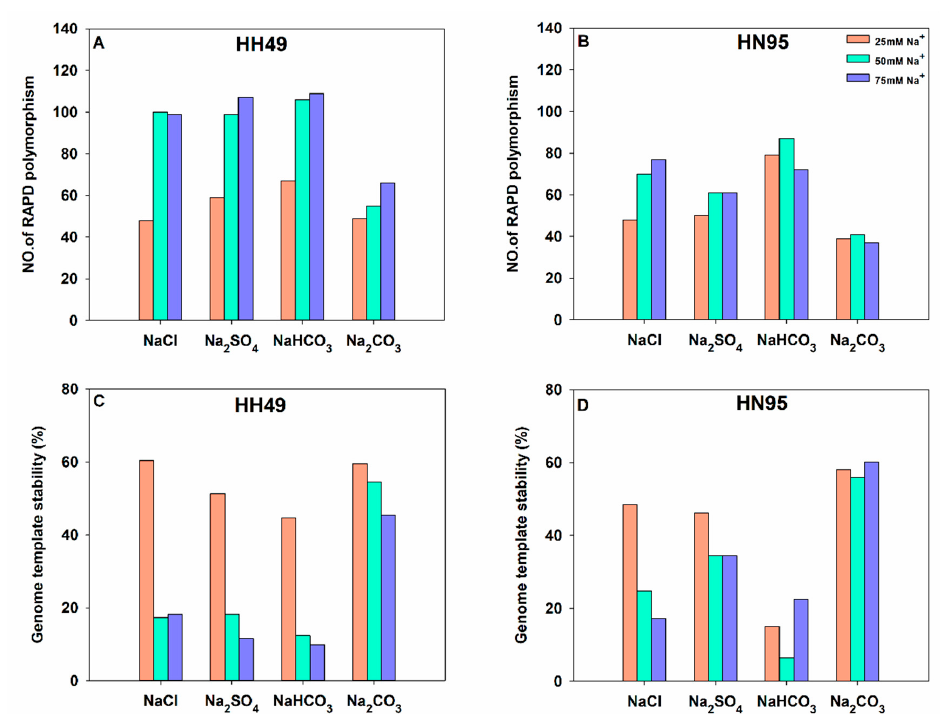
Figure 6. DNA damage of soybean seedling roots treated with different salt stresses for 3 days. The RAPD polymorphism of HH49 ( A ) and HN95 ( B ) seedling roots were amplified using random primers. The genome template stability of HH49 ( C ) and HN95 ( D ) seedling roots. To assess RAPD, if the control and salt-treated PCR amplification products displayed different electrophoretic motilities (RAPD polymorphisms appeared or disappeared), the case was scored as positive for RAPD. For all treatments, bands were considered reproducible and were used for polymorphism analysis when simultaneously detected in at least two experimental replicates.